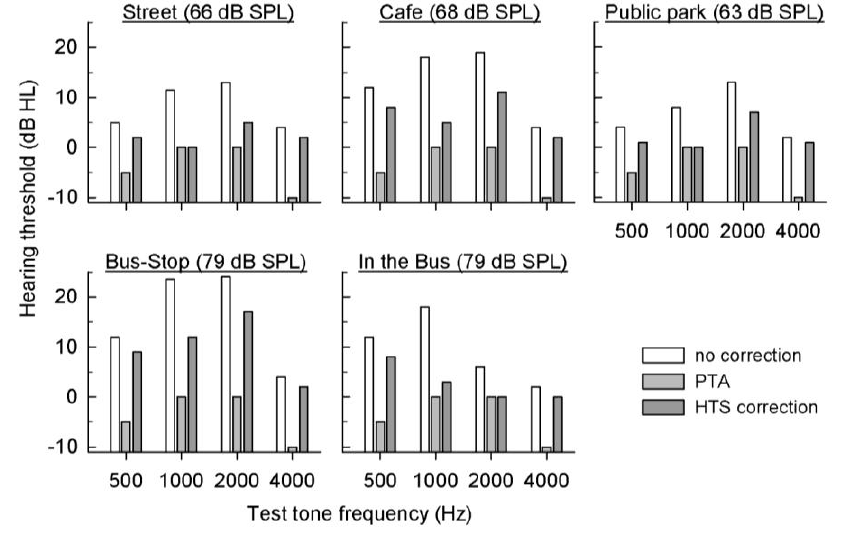
Figure 8. Hearing thresholds of the 500, 1000, 2000, and 4000 Hz tone tests outside the